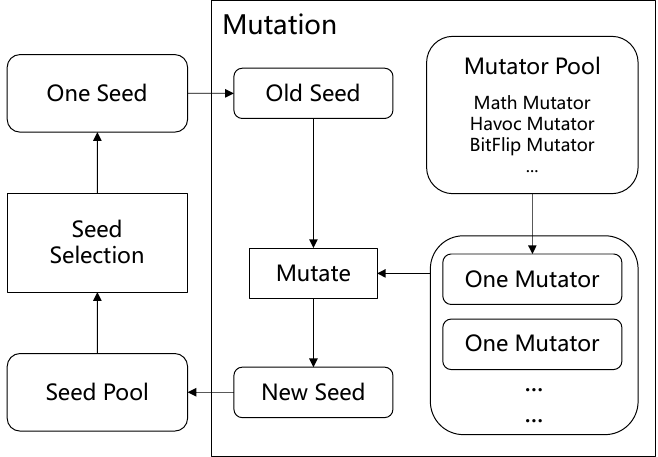
Figure 6. Overall fuzzing work